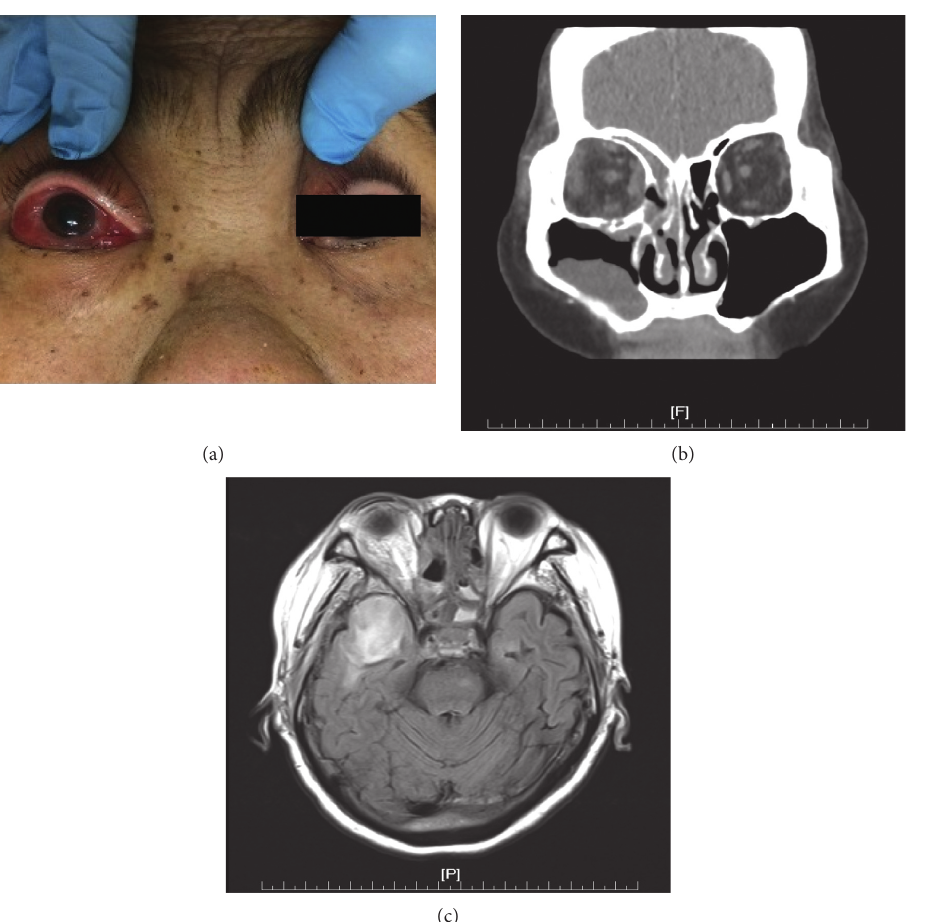
Figure 2: This was a 67-year-old female patient. Her pathological diagnosis was Mucor spp. She died 26 days after admission. (a) She presented as right eye blurry vision, limited extraocular movement, conjunctival injection and chemosis, and mild proptosis. (b) Computed tomography revealed orbital infiltration and subperiosteal abscess. Fluid accumulation over the frontal, ethmoid, and maxillary sinuses was seen. (c) Magnetic resonance imaging showed ipsilateral brain edema over the temporal region. This was taken 18 days after the CT image